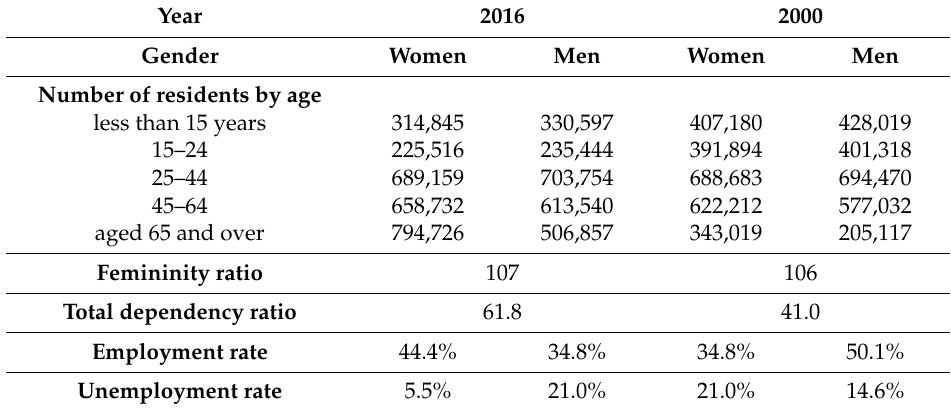
Table 1. Distribution of selected demographic characteristics in the population of the Silesian